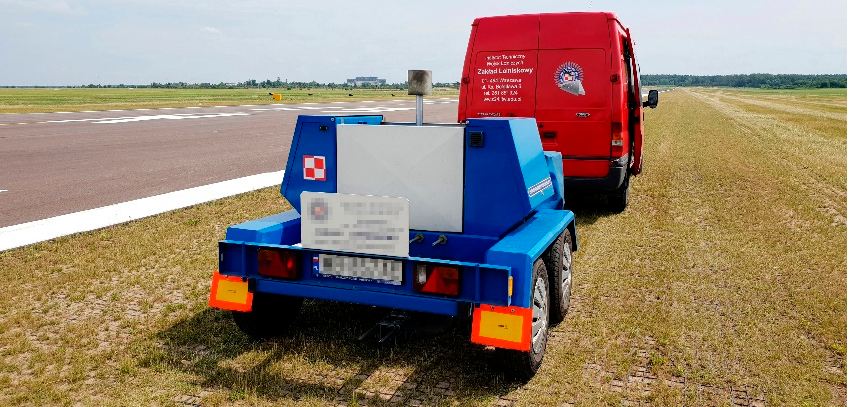
Figure 20. Measurement of load carrying capacity with HWD airport deflectometer.